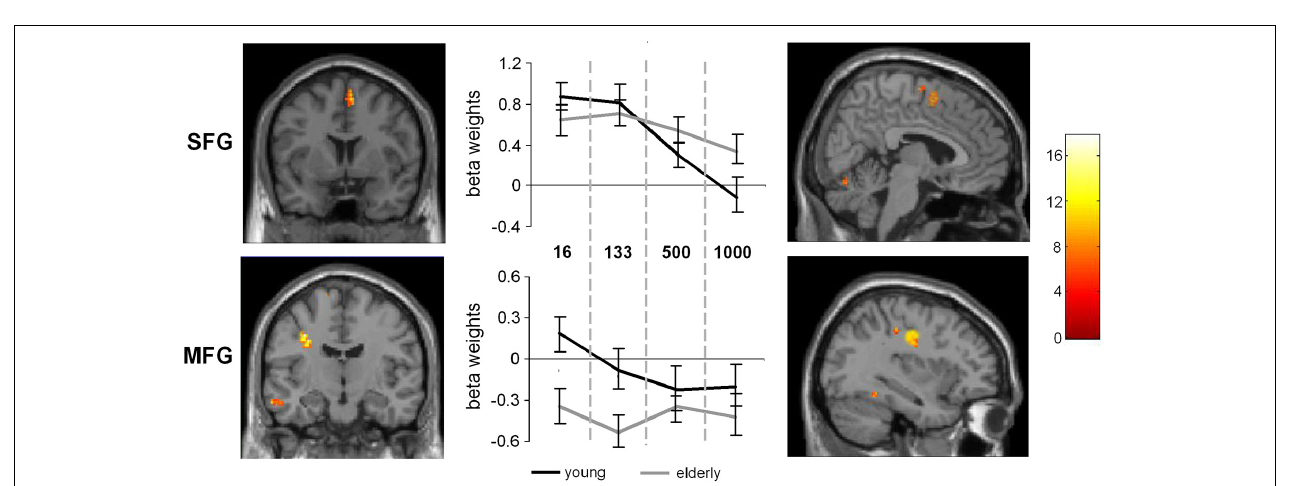
FIGURE 4 | Interaction of SOA × age. The left part of the figure denotes the frontal view of the activated regions (SFG and MFG), the right part denotes the sagittal view of the activated brain regions ( p < 0 . 001; k > 30 voxels). The